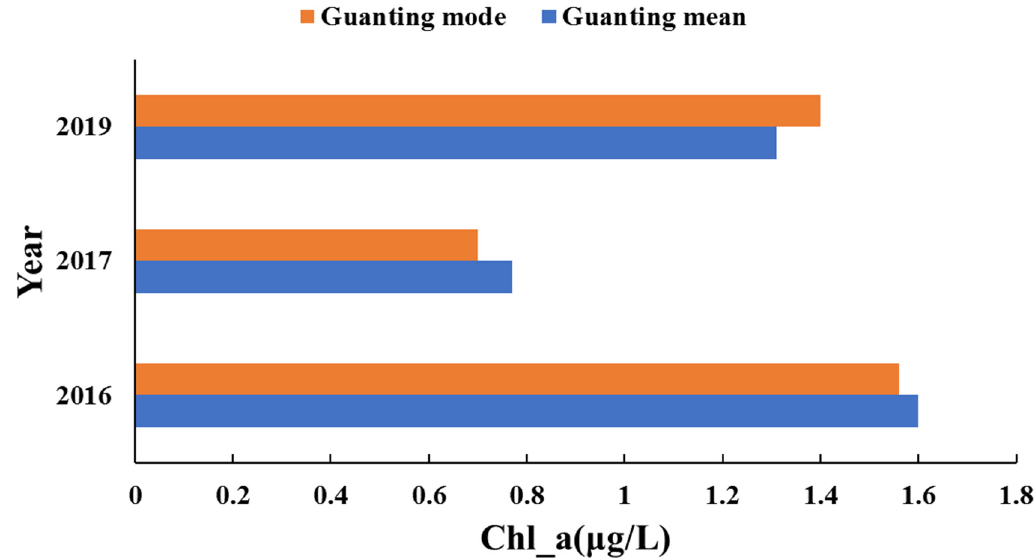
Figure 5. Annual mean and mode changes of chlorophyll-a concentrations in the Guanting Reservoir based on Landsat satellite images. From 2016 to 2017, the concentration of chlorophyll-a in the Guanting Reservoir decreased. In 2019, the concentration slightly increased.